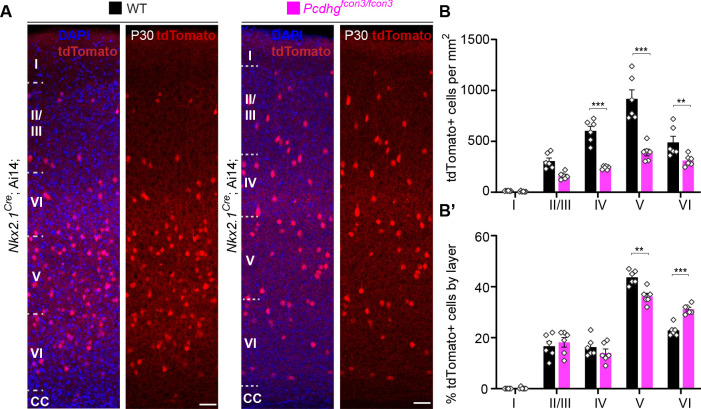
Cortical layer distribution of Nkx2.1-derived cINs in Pcdhg WT and mutant mice.(A) Representative photographs of the primary visual cortex (V1) in Nkx2.1Cre;Ai14;Pcdhg+/+ (Pcdhg WT) and Nkx2.1Cre;Ai14;Pcdhgfcon3/fcon3 (Pcdhg mutant) mice at P30. Scale bar 50 μm. (B) Quantification of tdTomato+ Nkx2.1-derived cINs in layers I-VI of visual cortex of Pcdhg WT and mutant mice at P30 (2-way ANOVA, Fgenotype = 91.70, P value<0.0001, adjusted p values ***p<0.0001, **p=0.015, n = 6 mice of each genotype). (B’) Layer distribution of tdTomato+ Nkx2.1-derived cINs shown as percentage tdTomato+ cells per layer in V1 of Pcdhg WT and Pcdhg mutant mice at P30 (2-way ANOVA, Fgenotype = 1.75e-003, P value=0.95, adjusted p values ***p=0.0001, **p=0.0005, n = 6 mice of each genotype).
Figure 3—figure supplement 3—source data 1.Quantification of Nkx2.1-derived cINs by cortical layer in the visual cortex of controls and Pcdhg loss of function mice.